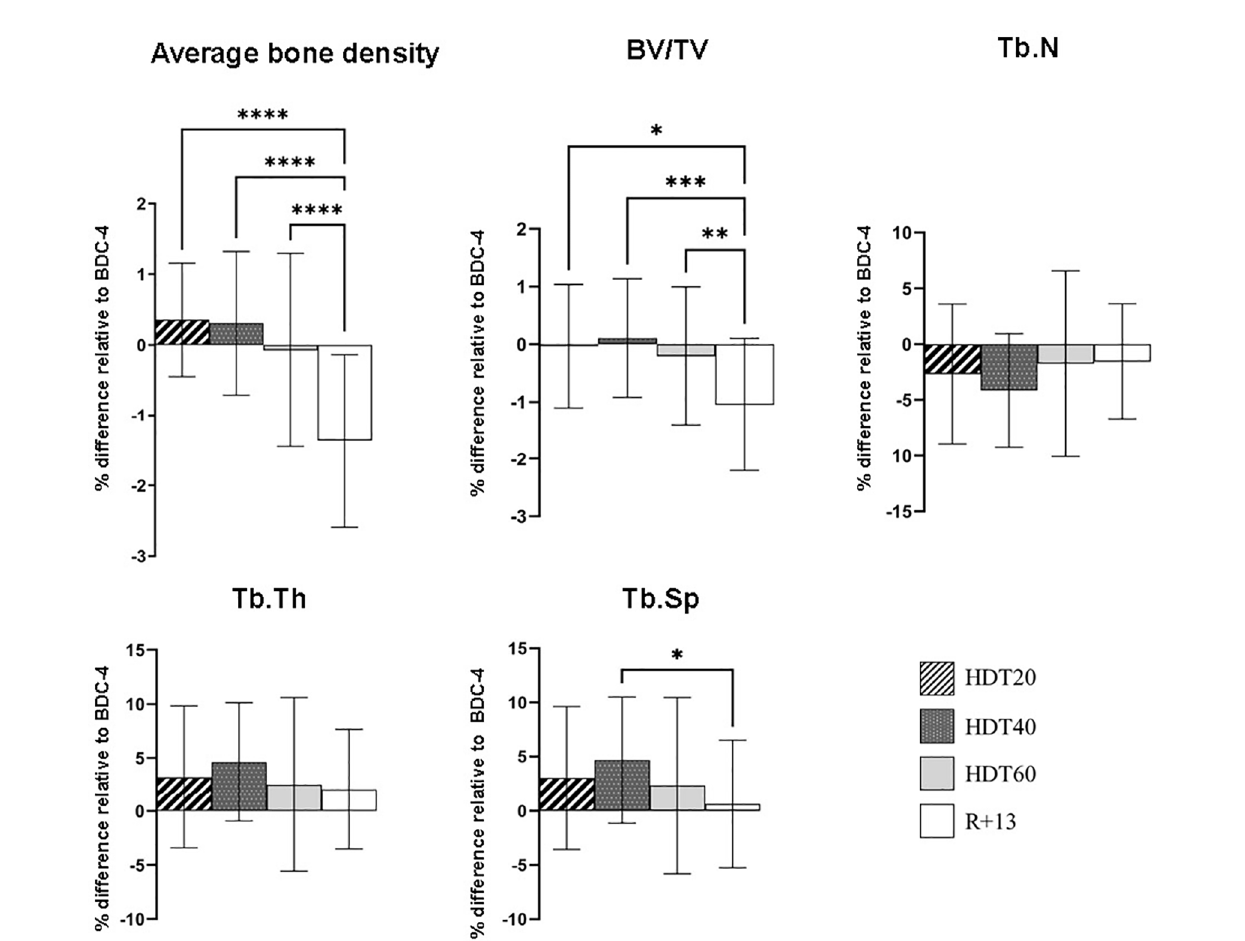
FIGURE 5 | Changes in left tibia bone parameters during bed rest. As no statistically signi fi cant differences between the control and cocktail groups were observed, individuals of both groups were pooled. n = 20. Values are expressed as the percentage of difference relative to BDC-4 ± SD. Statistically signi fi cant differences were revealed using either one-way ANOVA or a linear mixed effects model analysis. *p < 0.05; **p < 0.01; ***p < 0.001, ****p < 0.0001. BV/TV, bone volume fraction; Tb.N, trabeculae number; Tb.Th trabecular thickness; Tb.Sp trabecular